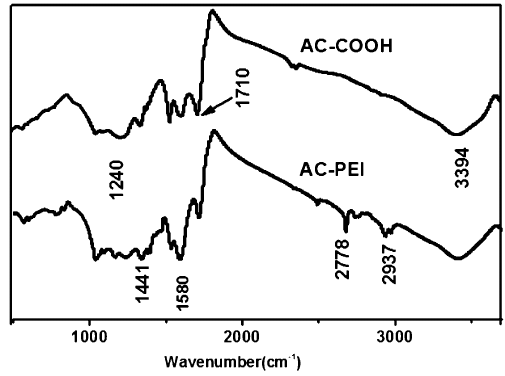
Fig. 1 FTIR spectra of AC-COOH and